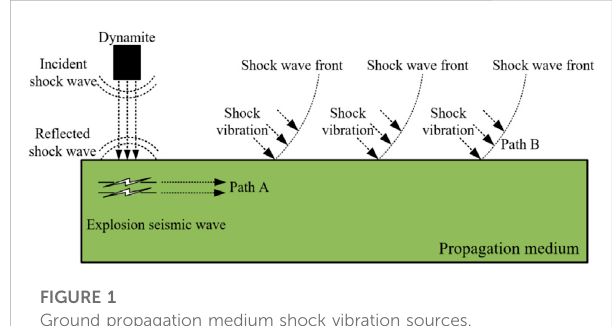
FIGURE 1 Ground propagation medium shock vibration